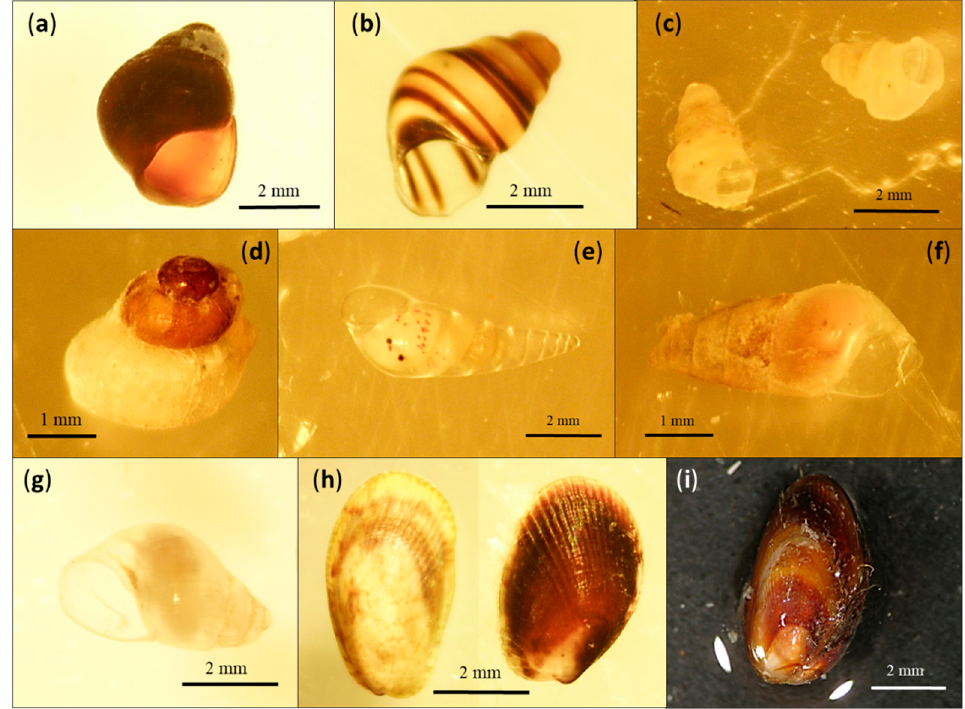
Figure 2. Species novel to the BOLD database: ( a ) Eatonina sp., ( b ) Eatonina cossurae , ( c ) Alvania cf. carinata , ( d ) Crisilla cf. maculata , ( e ) Vitreolina antiflexa , ( f ) Odostomia plicata , ( g ) Megastomia winfriedi , ( h ) Musculus cf. costulatus , ( i ) Gregariella semigranata .